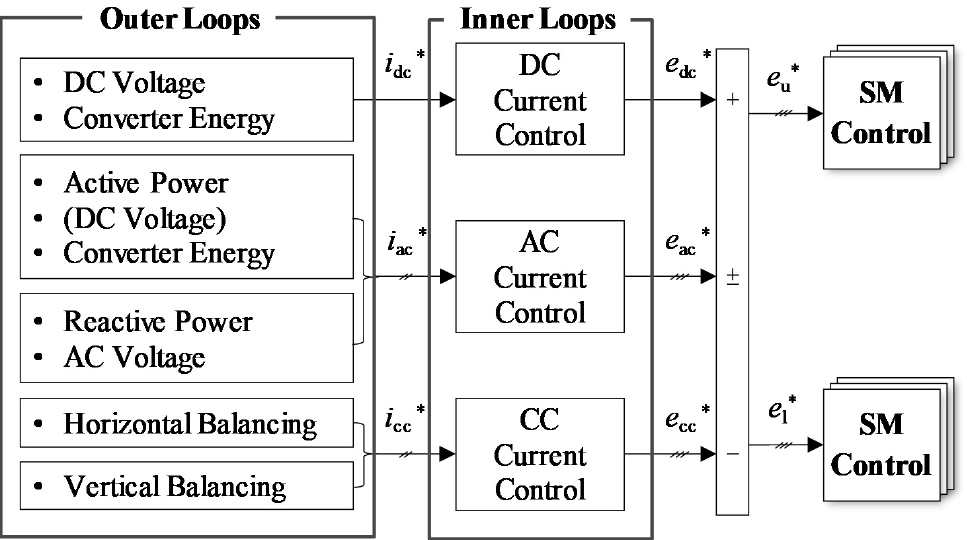
Figure 3. MMC Control Structure (reference signals denoted with (*)).